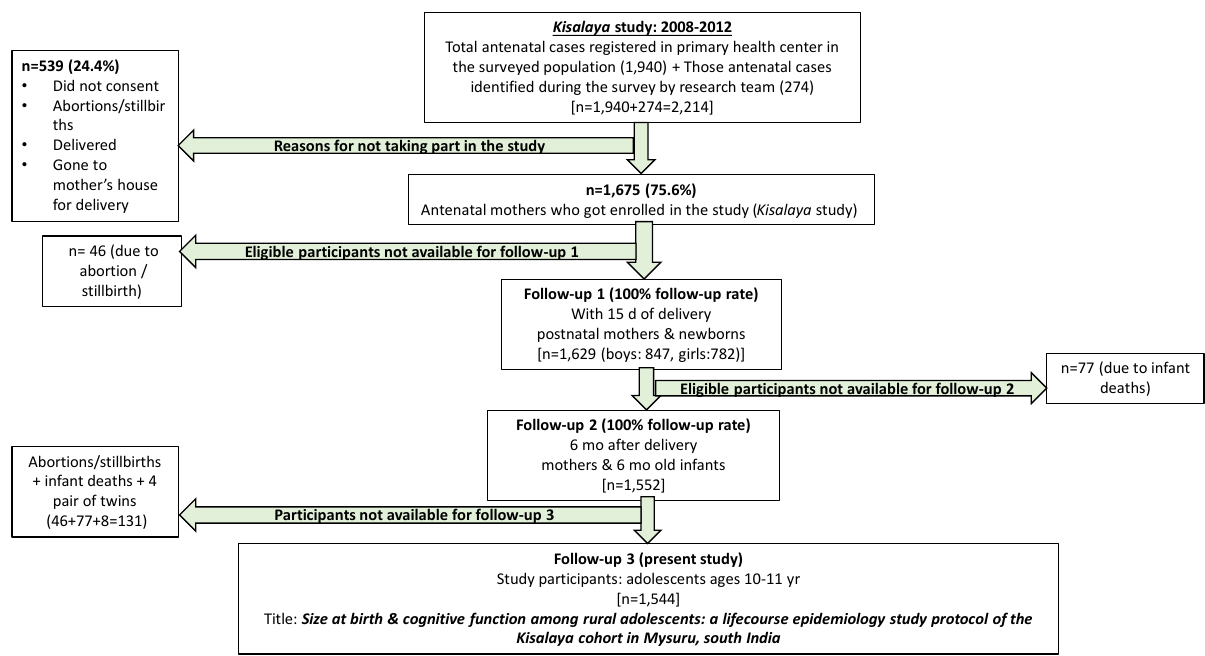
Figure 2: Depicting the follow-up of Kisalaya